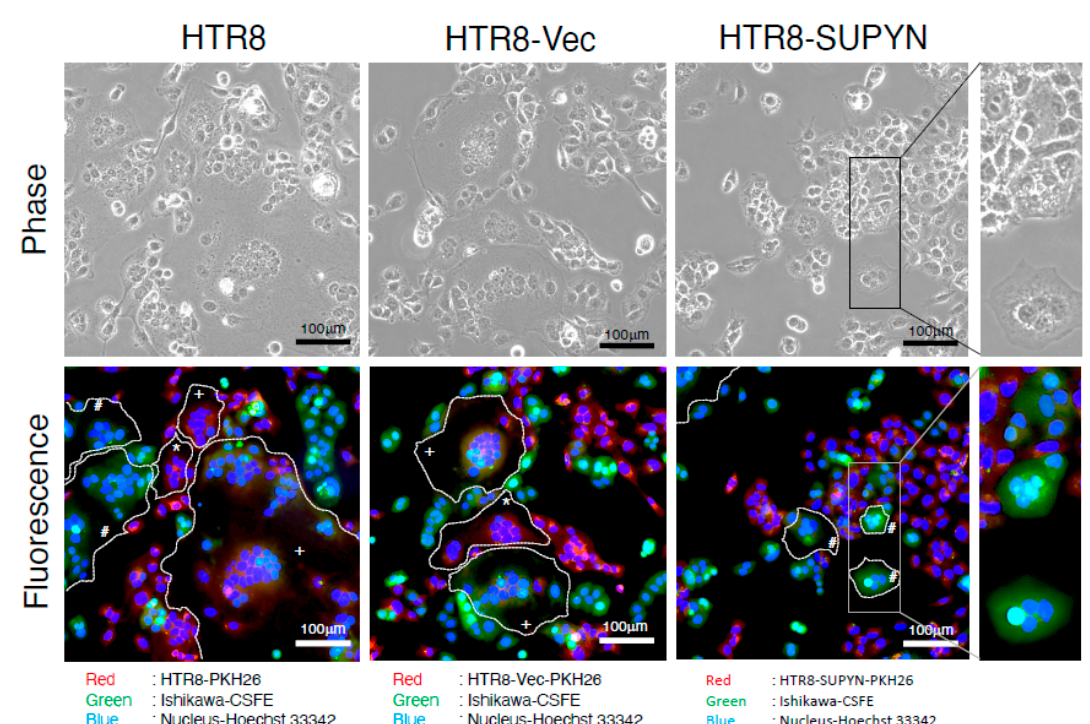
Figure 3. In vitro analysis of syn1-induced homotypic and heterotypic trophoblast/endometrial epithelial cell fusion and the effects of SUPYN. HTR8 trophoblast cells, HTR8 cells stably transfected with a control vector (HTR8-Vec) and HTR8 cells stably transfected with a vector driving SUPYN expression (HTR8-SUPYN) were stained with a red dye and Ishikawa endometrial cells with a green dye and placed in co-culture. All cell nuclei were counterstained blue with Hoechst 33342. In the left and middle panels, HTR8 (red; far left) and HTR8-Vec (red, middle left) TB cells were transiently transfected with a plasmid driving the expression of syn1 prior to co-culture with Ishikawa endometrial cells (green). In the right panels, HTR8-SUPYN cells were transiently transfected with a plasmid driving the expression of syn1 prior to co-culture with Ishikawa endometrial cells (green). Phase contrast images are presented for comparison to aid in distinguishing cell boundaries. A magnified area is shown in the far-right column. Red-red HTR8 homotypic fusion is depicted with asterisks (*); green-green Ishikawa homotypic fusion is depicted with a pound sign (#) and orange heterotypic HTR8/Ishikawa cell fusion with a plus sign (+).